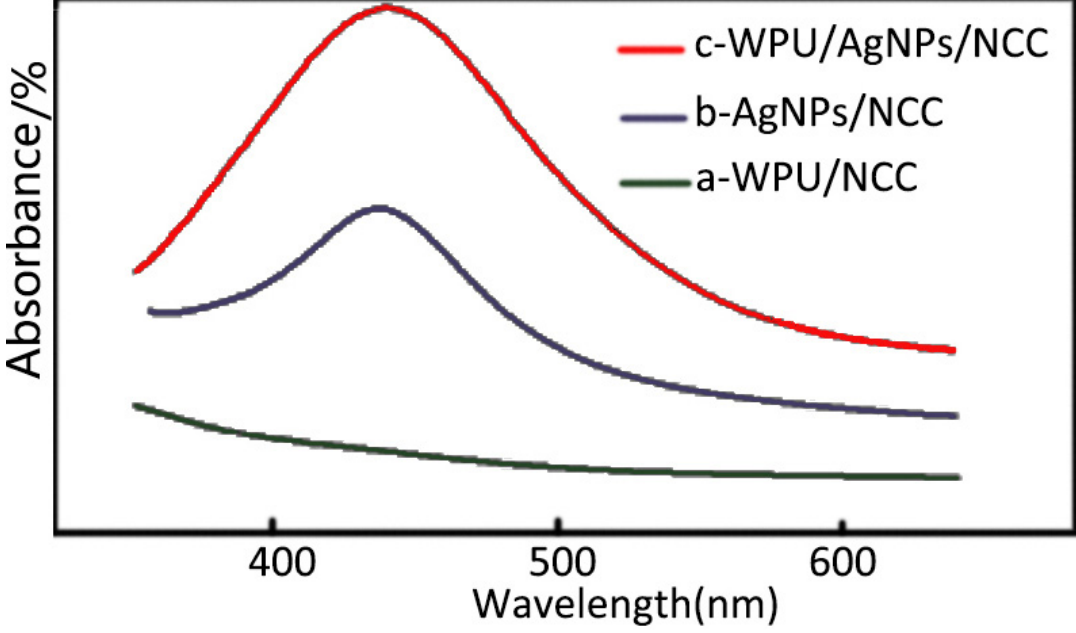
Figure 5. UV-vis spectra of ( a ) WPU/NCC, ( b ) NCC/AgNPs, and ( c ) WPU/NCC/AgNPs.